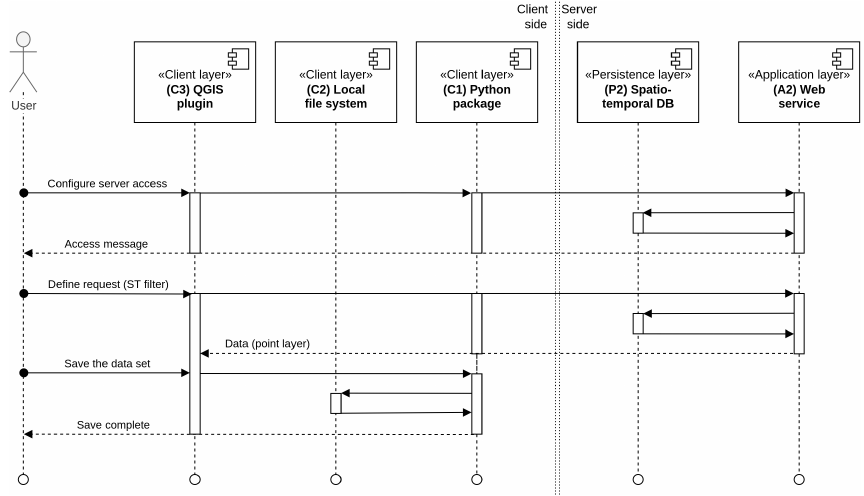
Figure 6. ST_LUCAS dynamic architecture of the system user